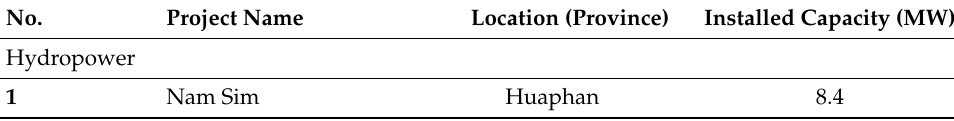
Table A3. List of power projects to be developed by 2030 indicated in the NPDS 2021-2030.